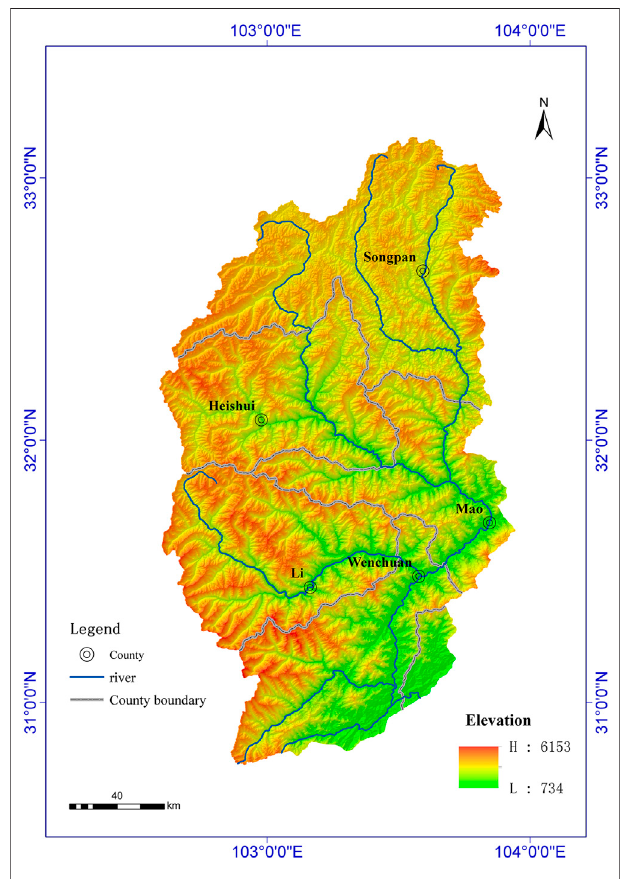
FIGURE 2 | The topography of the upper reaches of the Min River.